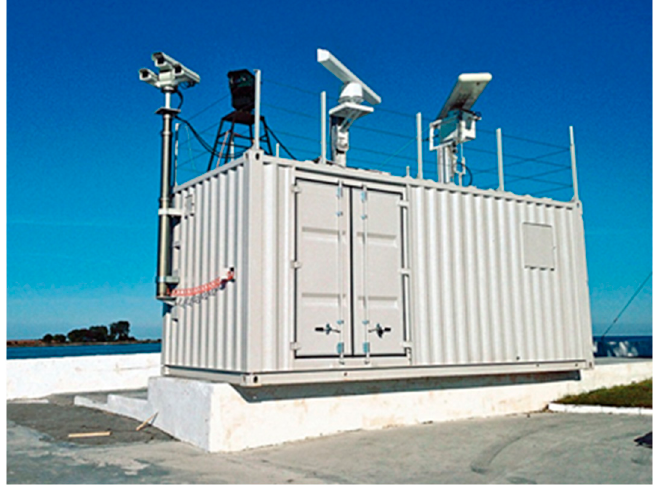
Figure 8. Appearance of the coastal radar [58].